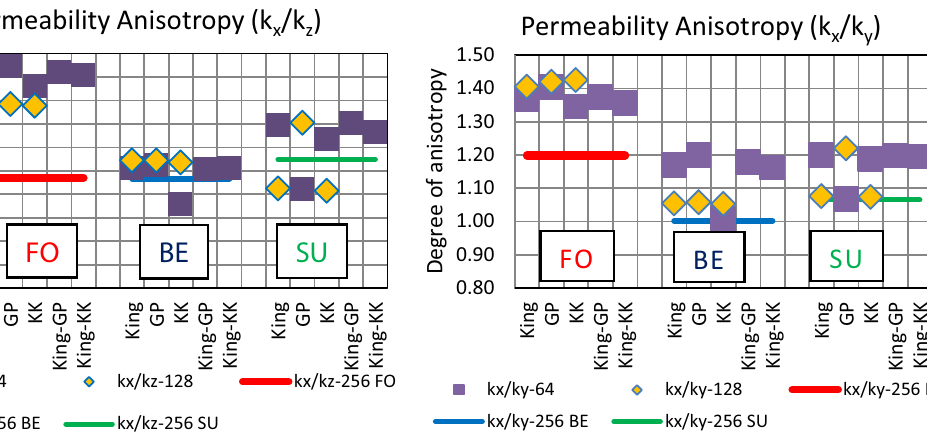
Fig. 8 Permeability anisotropy of the